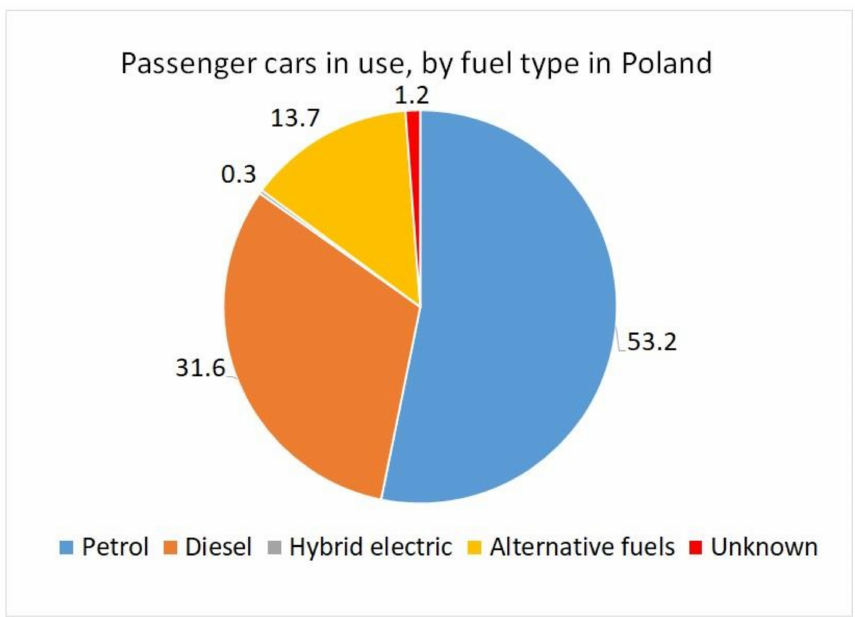
Figure 2. Classification of passenger cars by fuel type (own drawings based on